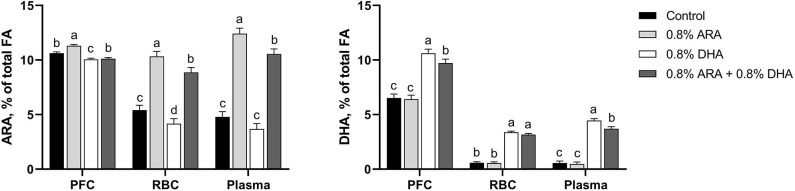
Tissue ARA and DHA concentrations (% of total FA) of pigs receiving experimental milk replacers differing in ARA and DHA fatty acid concentrations. a−dSuperscript letters denote treatment means differ (P < 0.05). Values represent least square means of 11–12 pigs per treatment. ARA, arachidonic acid; DHA, docosahexaenoic acid; FA, fatty acid; PFC, prefrontal cortex; RBC, red blood cell.